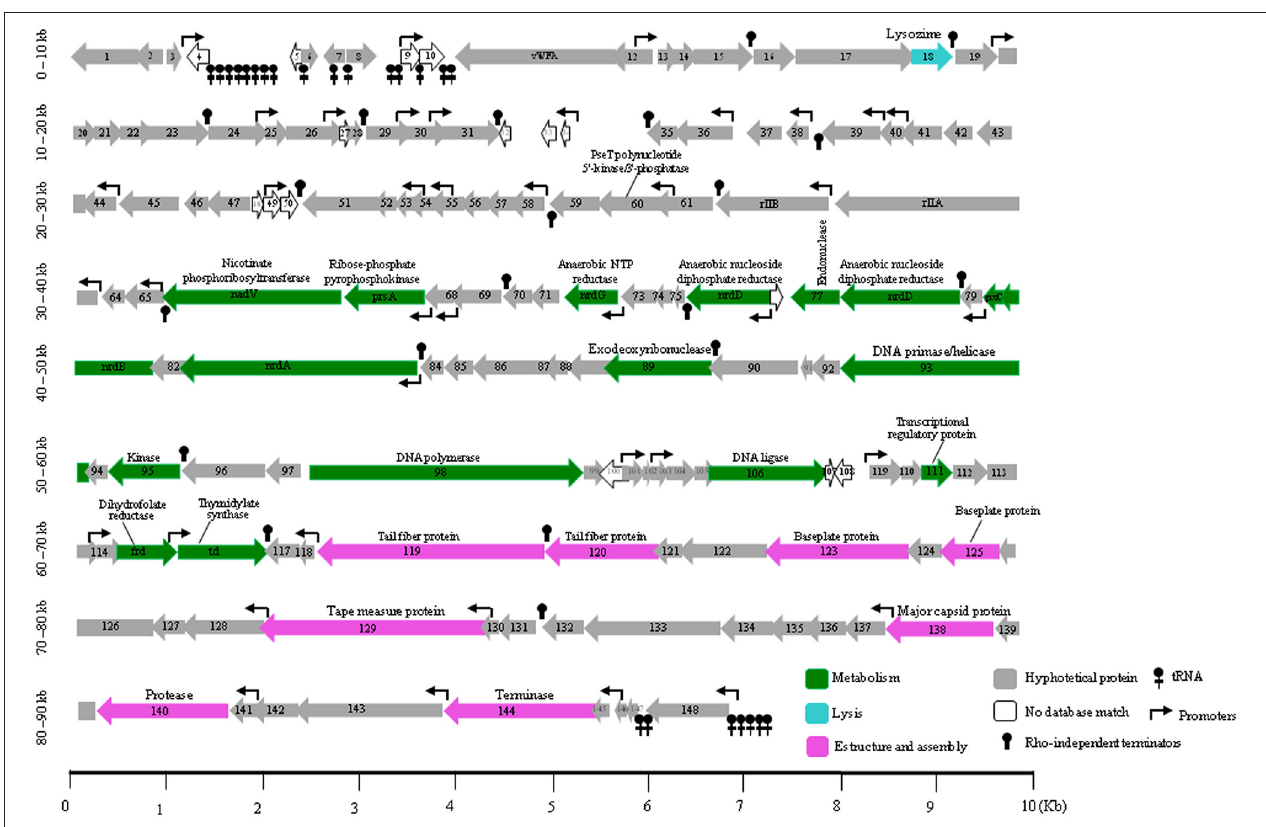
FIGURE 4 | Genomic structure of UAB_Phi87, including the Rho-independent terminators and tRNAs. Arrows represent genes, and the different colors identify the functional category into which the homologous genes were classified. Gene functions are indicated where they are known. The color code for gene function is provided at the bottom of the figure. ORFs are numbered consecutively from left to right as described in Table 3 , and are indicated by arrows pointing to the direction of transcription.